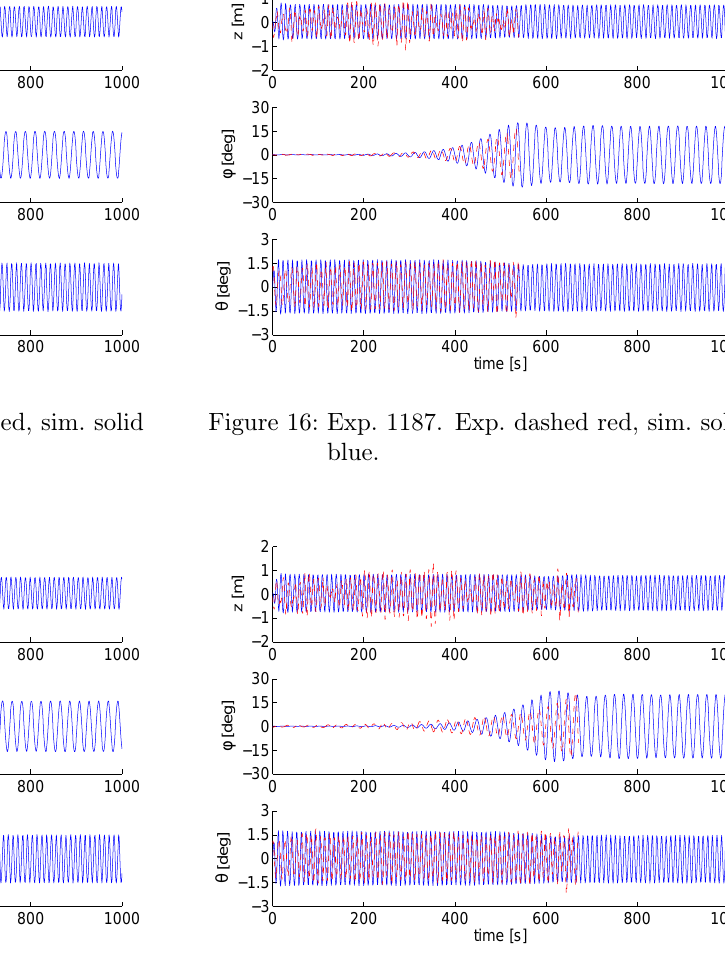
Figure 17: Exp. 1185. Exp. dashed red, sim. solid blue.